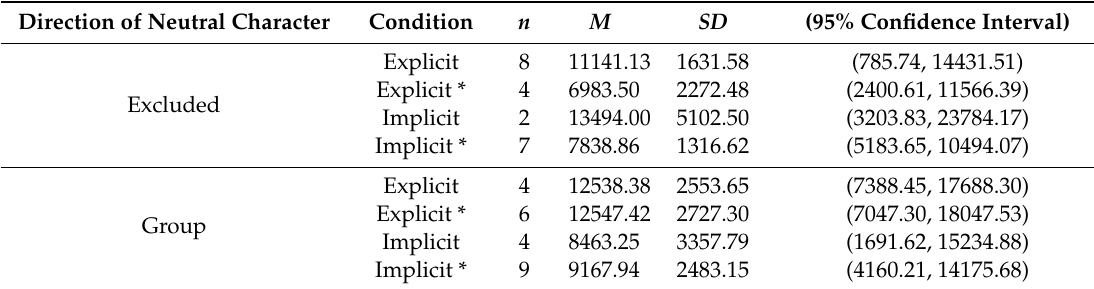
Table 4. Mean looking times at the end of the test trial in milliseconds.